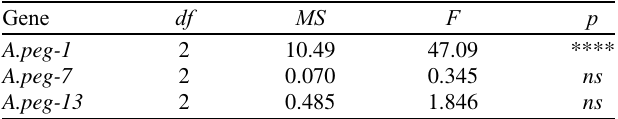
Table 2. One-way ANOVA analysis on the relative gene expression pro fi les of A.peg-1 , A.peg-7 and A.peg-13 , in response to temper- ature conditions.